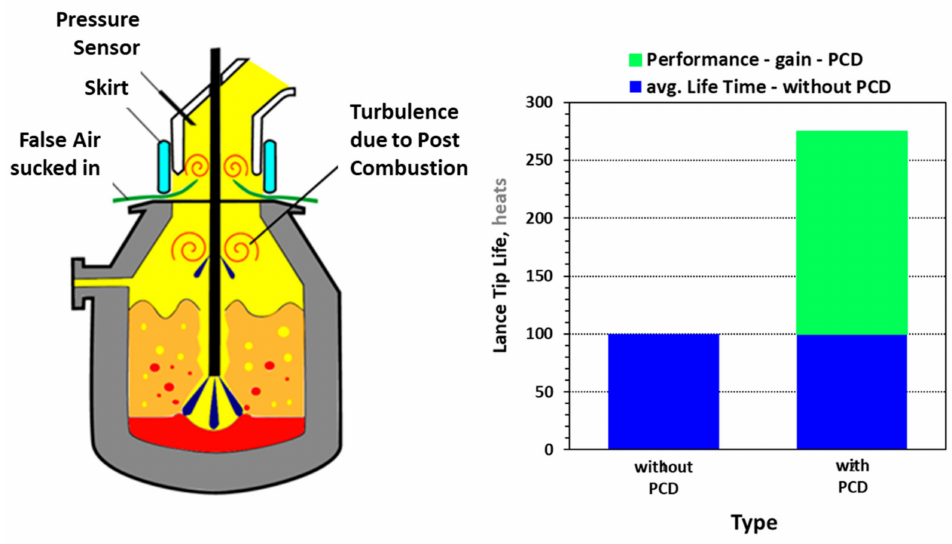
Figure 6. Advantage of PCD-units for increased lifetime of oxygen-blowing lance and lance tips [26]. At the same time, this technique reduces the skulls in the top cone area of the